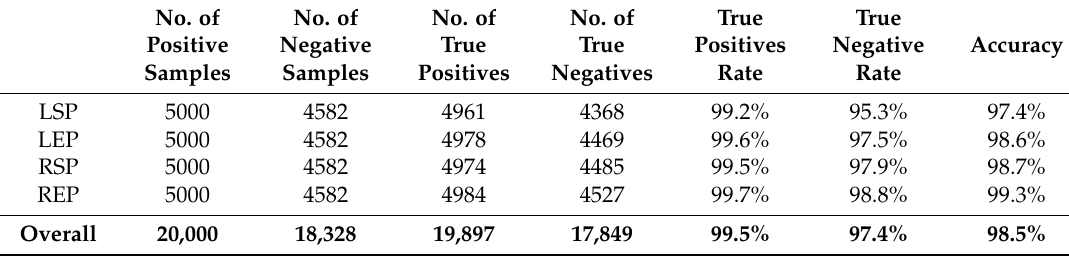
Table 4. Performance of the CNN-based lane endpoint